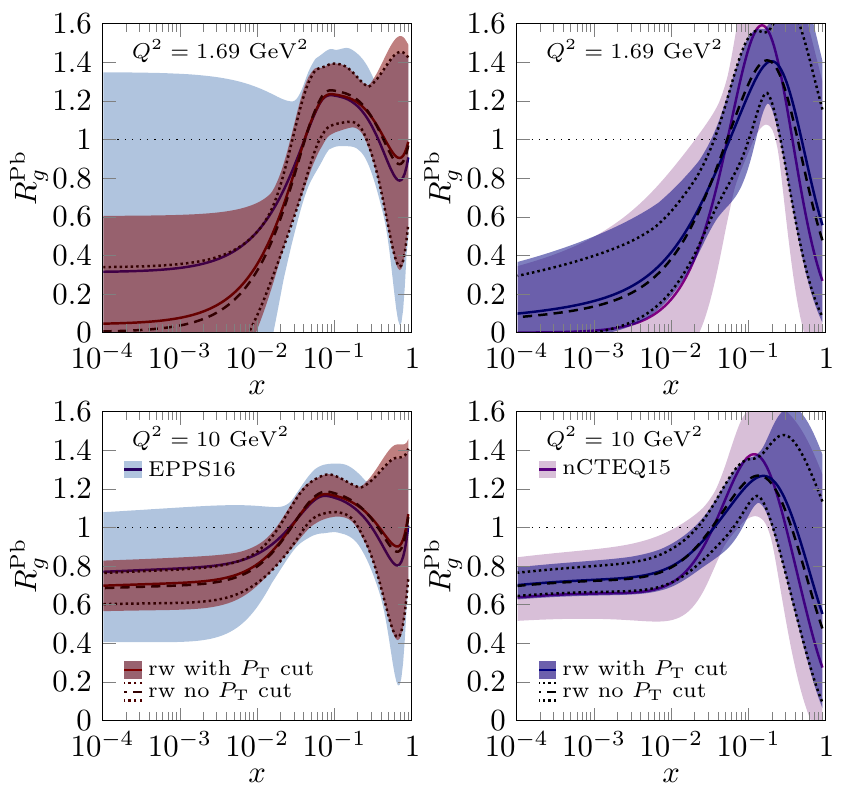
Figure 12 . The EPPS16 (left) and nCTEQ15 (right) nuclear modi(cid:12)cations for bound-proton PDFs in Pb nucleus before (EPPS16 blue, nCTEQ15 purple), after reweighting with the LHCb data with P T > 3 GeV (EPPS16 red, nCTEQ15 blue), and including all data points (dotted curves). The results are shown at Q 2 = 1 : 69 GeV 2 (upper panels) and at Q 2 = 10 GeV 2 (lower